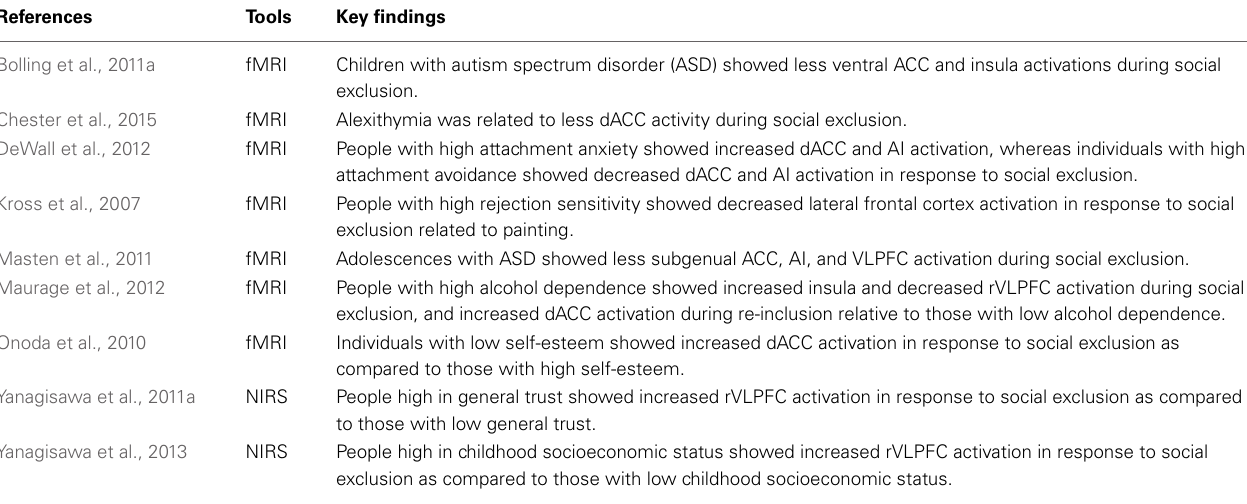
Table 3 | Key studies on individual differences of intrapersonal and interpersonal processes of social